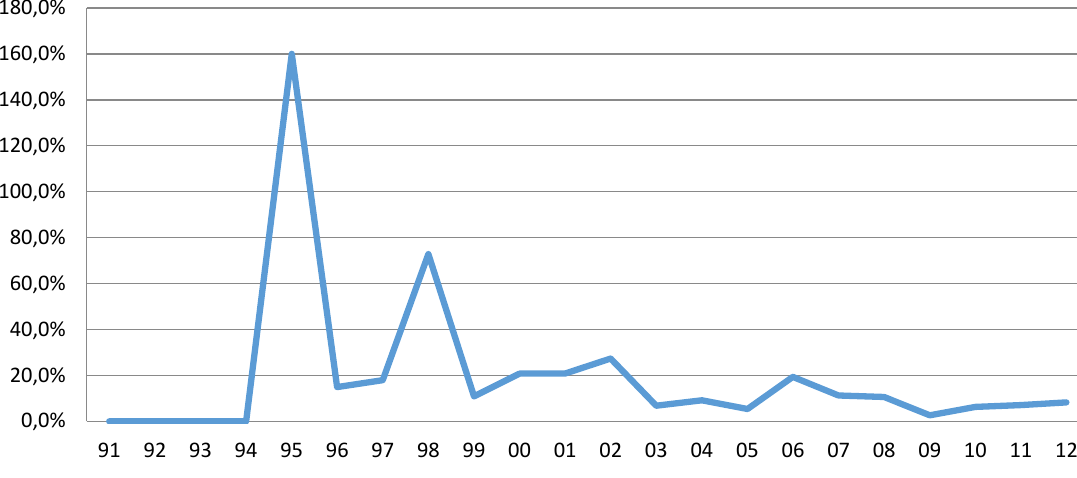
Figure 3. Evolution of the mean year-on-year rate of variation in the portfolio of recipients, indicator B7